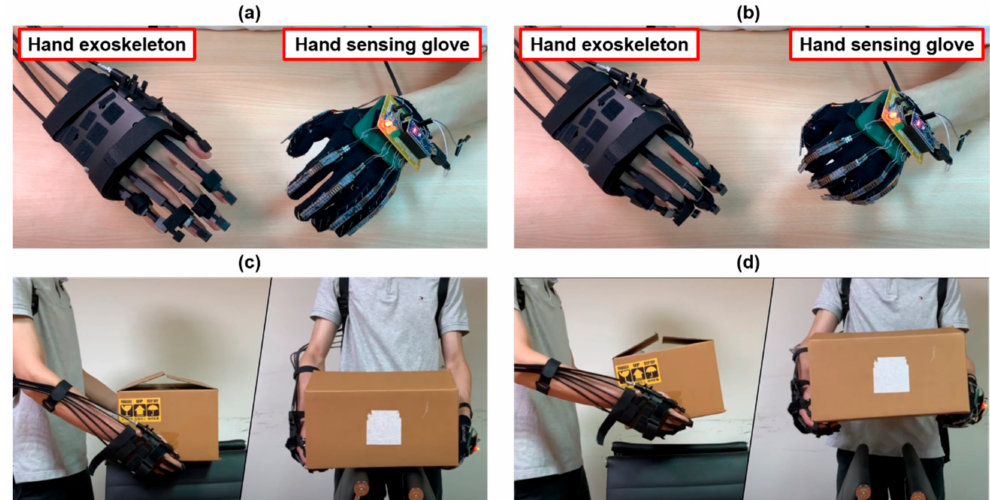
Figure 11. Bilateral hand training ( a , b ) and application of the hand exoskeleton for activities of daily living ( c , d